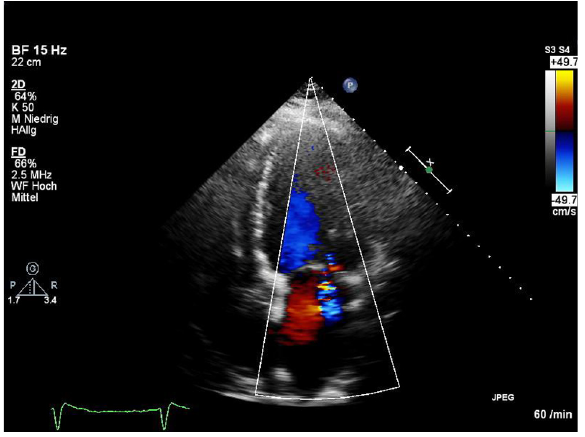
Figure 5 . Echocardiogram on day 3, post-procedural with resid- ual mitral regurgitation.